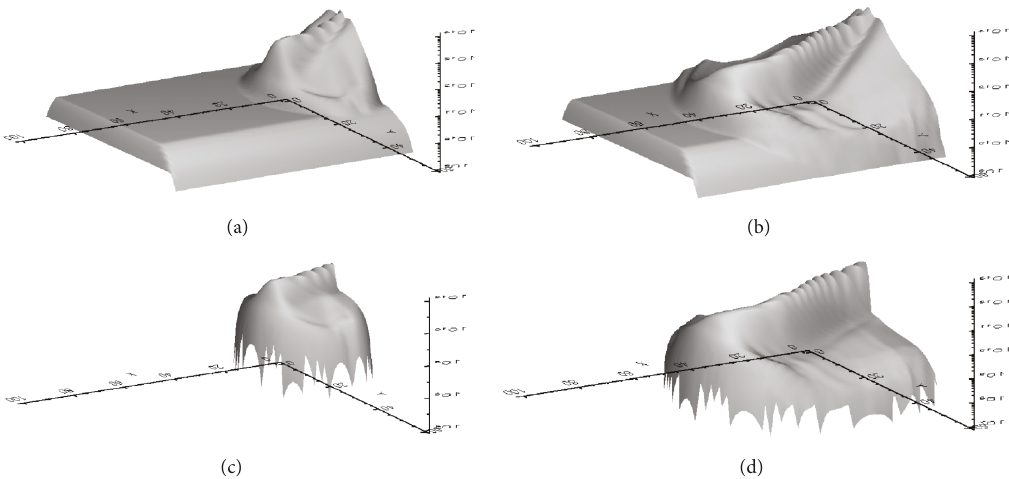
Figure 4: Scenario C (run3): illustration of the synthetic 𝛾 -ray images. In the plots the x-y plane defines the (synthetic) observation plane. 𝑧 -axis represents the intensity at each pixel of the observation plane (arbitrary units). For each one of the latter, a line of sight (LOS) is drawn that crosses the computational domain volume and ends up at the aforementioned pixel. The radiative intensity along the LOS is calculated using the radiative transfer equation. We see two different cases for emission coefficient used, with two snapshots for each case. In the first row, 𝜌 is used as emission coefficient (the intensity appears higher when the matter is denser). In the second row, 𝜌𝑢 2 is used as emission coefficient.The fast-moving jet matternow prevails in terms of 𝛾 -ray intensity, as compared to the clearly lower emission from slower moving surrounding material. In both configurations, we see the distinct signature of the precessing jet on the bent jet emission patterns formed, as well as on resolution effects at a faster pace than the rest of runs. In order to compare those images to actual observations, one would have to convolve them with the “beam” of the observing instrument, as it is provided by the operator. As a first step, it is possible to compare the sensitivity of an observing gamma-ray instrument to the “sensitivity” of the synthetic images, using a process similar to the one described in